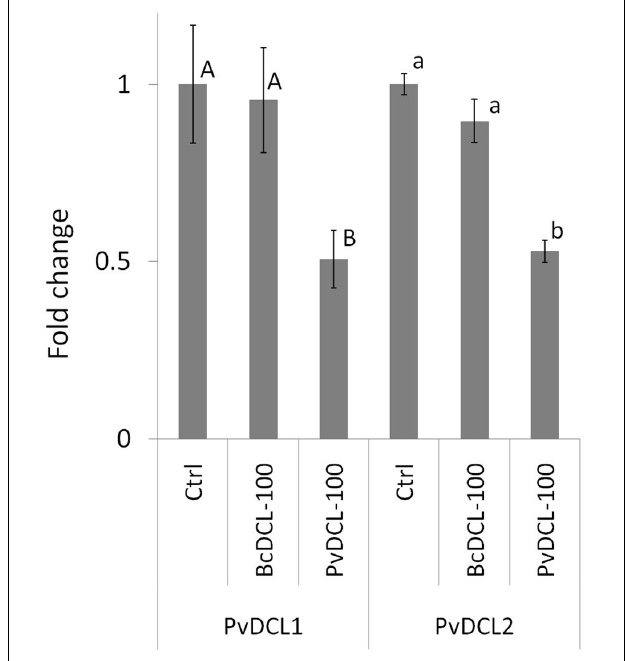
FIGURE 2 | Expression profiles of PvDCL1 and PvDCL2 following Plasmopara viticola inoculation on leaf samples treated with 50 µ l of water (ctrl) or 100 ng µ l - 1 of double-stranded RNA (dsRNA) of either BcDCL1/2 (BcDCL-100) or PvDCL1/2 (PvDCL-100). Gene expression level was determined by quantitative PCR (qPCR). Bars represent fold change of dsRNA-treated sample relative to ctrl sample at 7 days post inoculation. Normalization based on the expression levels of elongation factor, PveIF1b , was carried out before calculating fold changes. Error bar represents standard error of the mean of three biological replicates. Expression values followed by a common letter are significantly not different among samples, according to Tukey’s honestly significant difference test ( P ≤ 0.05), using one-way ANOVA of log2 [normalized relative quantity